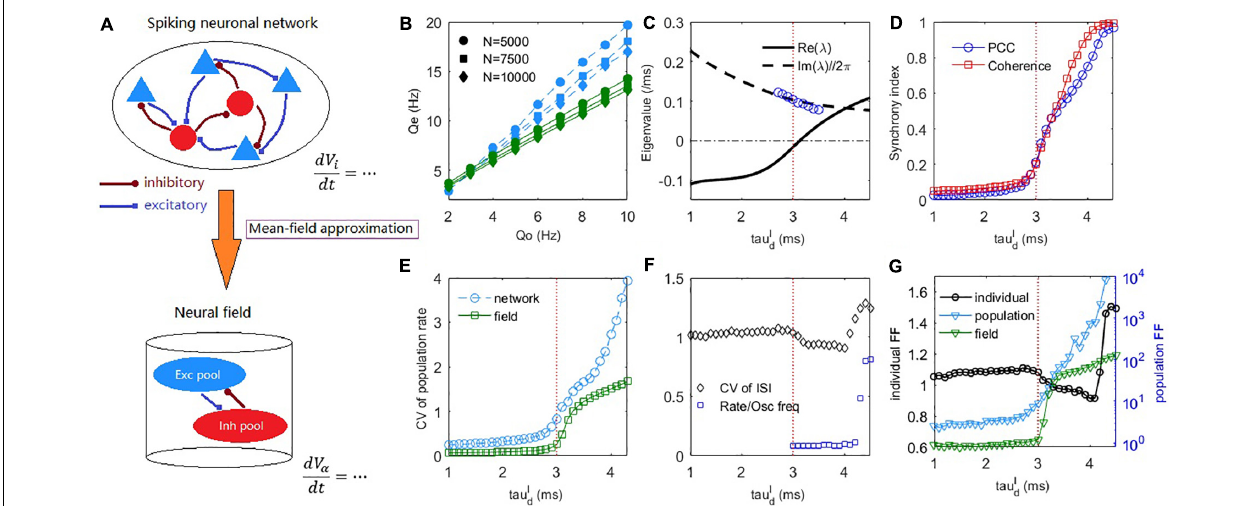
FIGURE 2 | The mean-field theory prediction of the dynamic transition of the spiking network. (A) A schematic diagram of the mean-field reduction from spiking neuronal network to macroscopic neural field. (B) The excitatory firing rate in the asynchronous steady-state ( τ I d = 1 ms ) under different strengths of external input and different network sizes. Blue symbols, obtained by the field equations with numerically estimated σ α under different input rates Q o , fits well with the network q simulations (blue dashed lines). Green symbol-lines are obtained by the field equations fixed σ α = J 2 α o n o Q o τ α for Q o = 5 Hz . Synaptic strengths J αβ are multiplied by 1.41 and 1.15 in the cases of N = 5000 and N = 7500, respectively to maintain the usual scale J αβ ∼ O ( N ( − 1 / 2 ) ). (C) Deterministic field equations predict that a Hopf bifurcation occurs with the increase of inhibitory decay time τ I d at a critical value around τ I d ≈ 3 ms (indicated by a vertical dashed line). The real part and imaginary part divided by 2 π of the dominant eigenvalue are denoted by the solid and dashed lines, respectively. Blue circles are peak frequencies of the excitatory firing rate oscillation from network simulation. (D) The PCC and coherence index show the emergence of network oscillation as τ I d increases. (E) The CV of population firing rate increases with the increase of τ I d . (F) The average CV of ISIs and the ratio between mean firing rate and peak frequency of network oscillation. (G) The average FF of individual neurons (left axis), and the FF of the network population spiking counts in network and field model (right axis). Time windows for measuring FFs are 50 ms . Averages are taken across the excitatory population for the measurements in panels (D–G) . The external input is set as Q o = 5 Hz in panels (C–G)